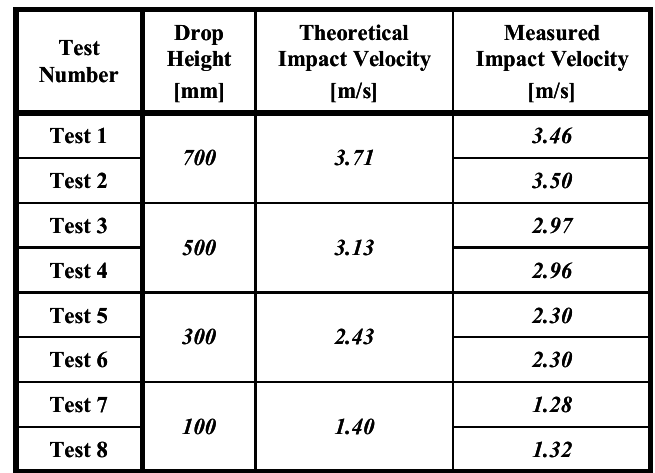
Table 1 Relationship between drop height and impact velocity. The actual velocity is less than the theoretical velocity because of the air resistance